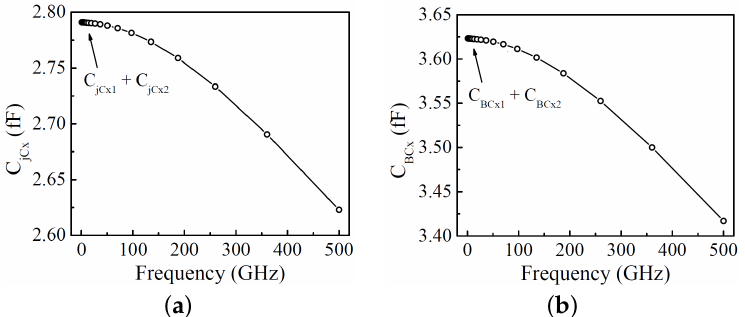
Figure 9. Frequency dependent capacitance characteristic following the customized TCAD structure shown in Figure 7a ( a ) and Figure 8a ( b ) for fbcpar